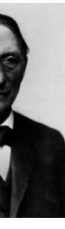
Figure 1. Title: Carl Ludwig (1816–1895), a pioneer of physiology, presented a new concept of renal function and cardiorenal interaction. Legend: Picture downloaded from https://research.uni-leipzig. de/agintern/UNIGESCH/ug175.htm (accessed on 17 May